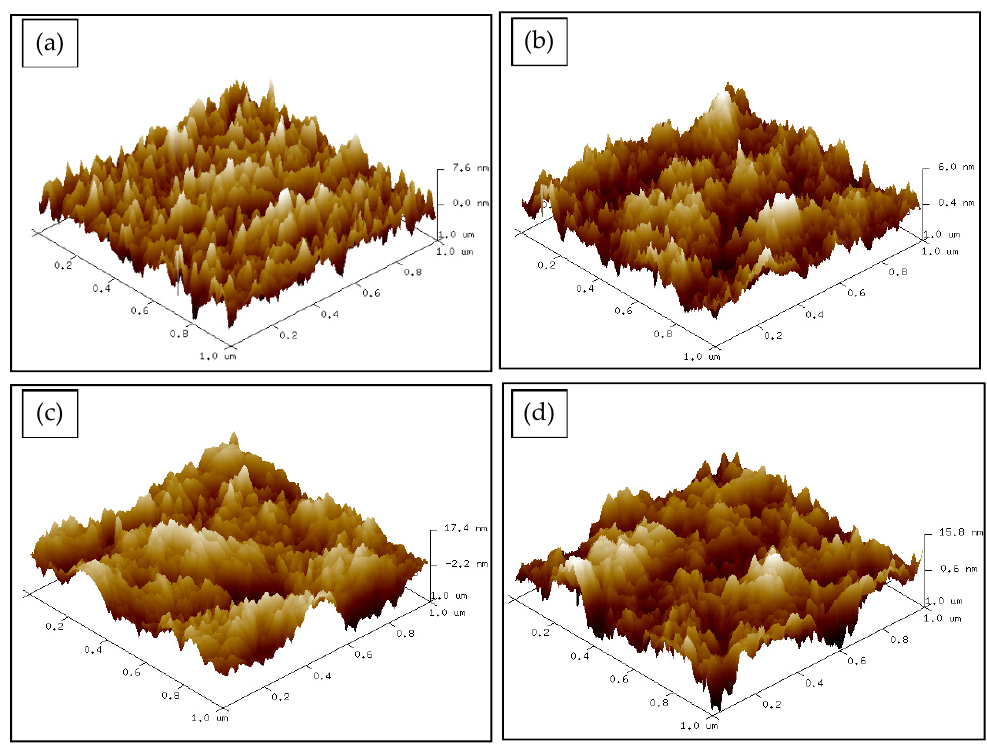
Figure 4. AFM topographic images in 3D of ( a ) NCC, ( b ) PEDOT, ( c ) NCC/PEDOT (before), and ( d ) NCC/PEDOT (after) thin films.